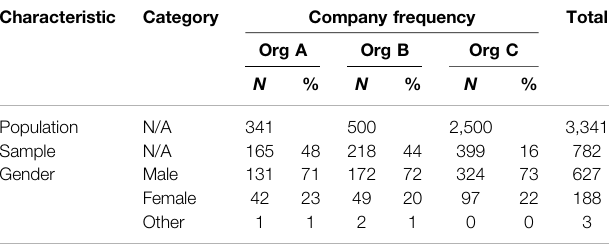
TABLE 1 | Population and sample for three case studies.